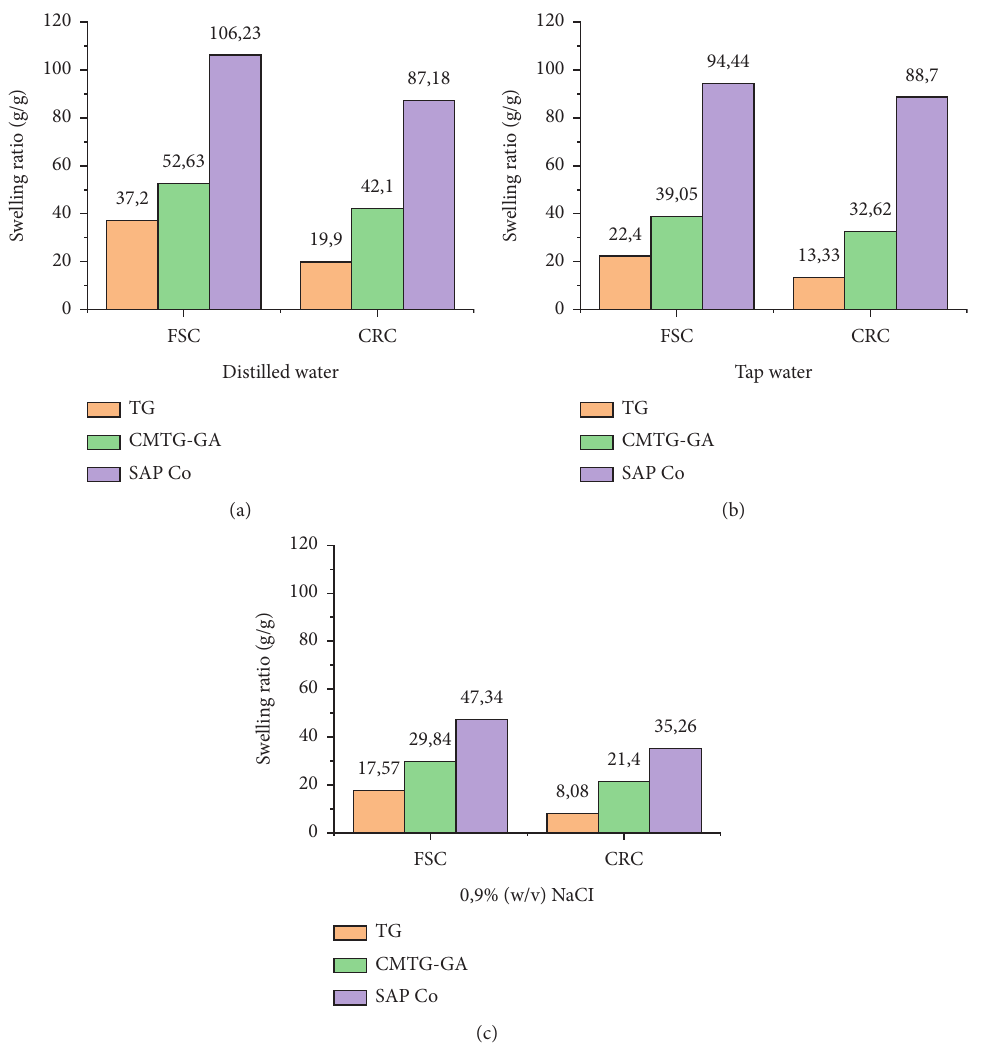
Figure 10: Swelling behavior of TG, CMTG-GA, and the commercial SAP (SAP Co) in distilled water, tap water, and 0.9% (w/v)